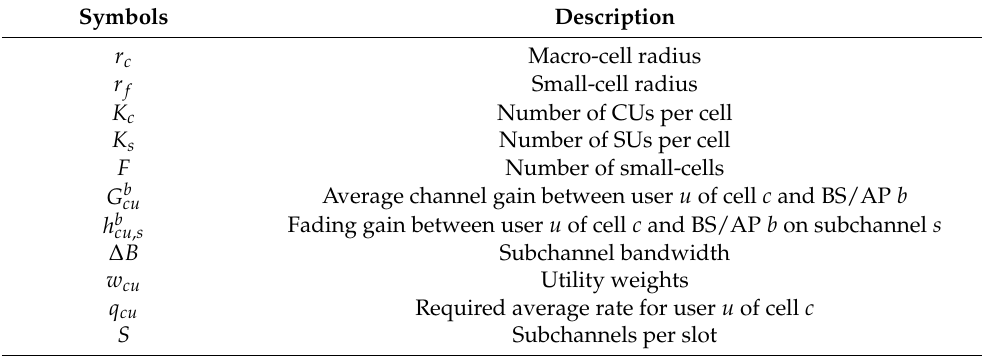
Table 1. Main symbols and